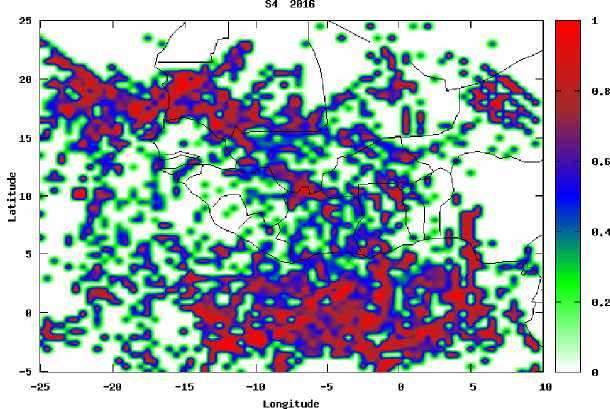
Figure 4. Low-latitude cumulative scintillation map for the first semester of